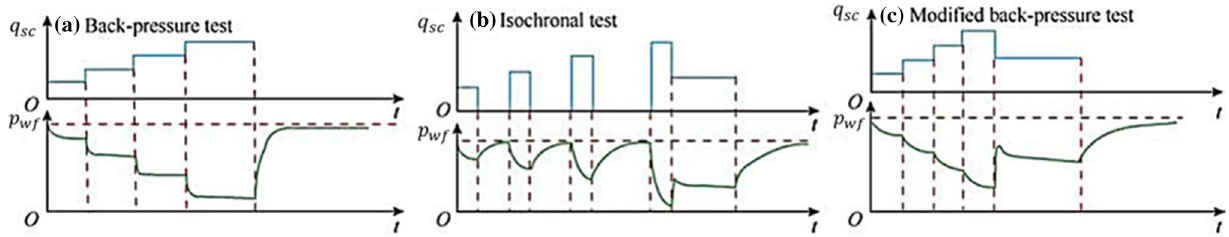
Fig. 1 Schematic representation of the backpressure test, isochronal test, and modified backpressure test (after Hui et al.